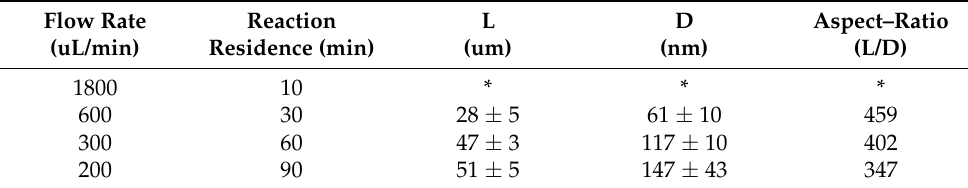
Figure 3. Flow-rate (reaction time)-dependent Ag NW growth. ( a – d ) Representative SEM images showing the morphology of Ag NWs grown at flow rates of 1800, 600, 300, and 200 uL/min, respec- tively. Inset shows the related size distribution of Ag NWs. Table 1. Effects of flow rate on aspect ratio of Ag